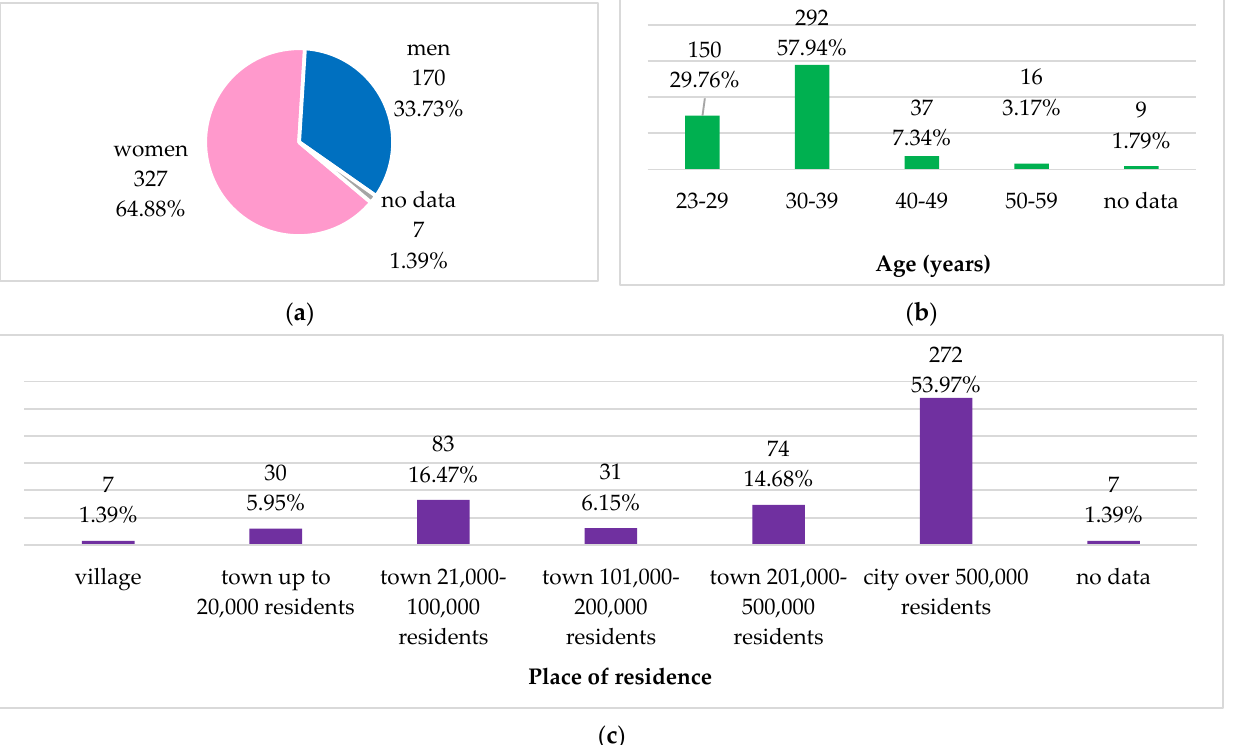
Figure 1. Demographic characteristics of the study group: ( a ) gender; ( b ) age groups; ( c ) place of residence.